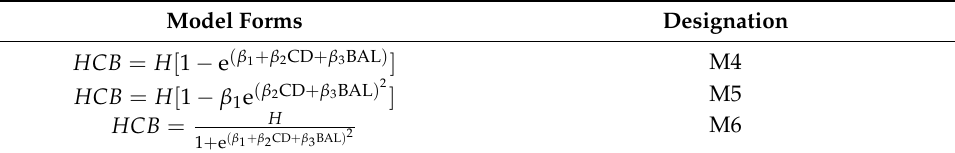
Table 4. Summarized forms of HCB functions, which were expanded through inclusion of various predictor variables.